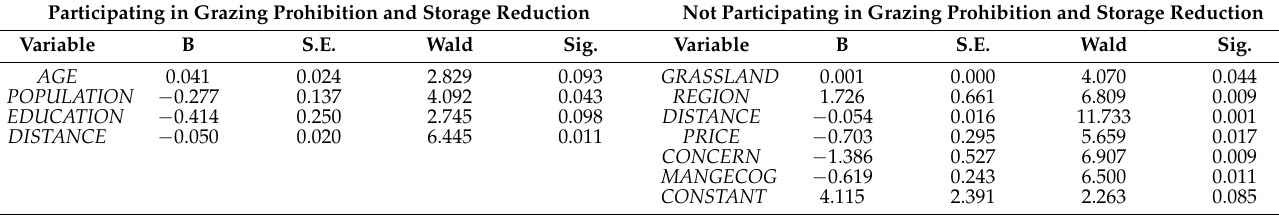
Table 7. Logistic regression for participation and nonparticipation in grazing prohibition and storage reduction. Participating in Grazing Prohibition and Storage Reduction